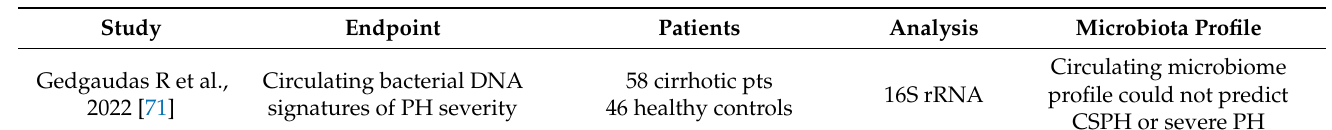
Table 1. Features of the gut microbiome associated with portal hypertension in animal models and human